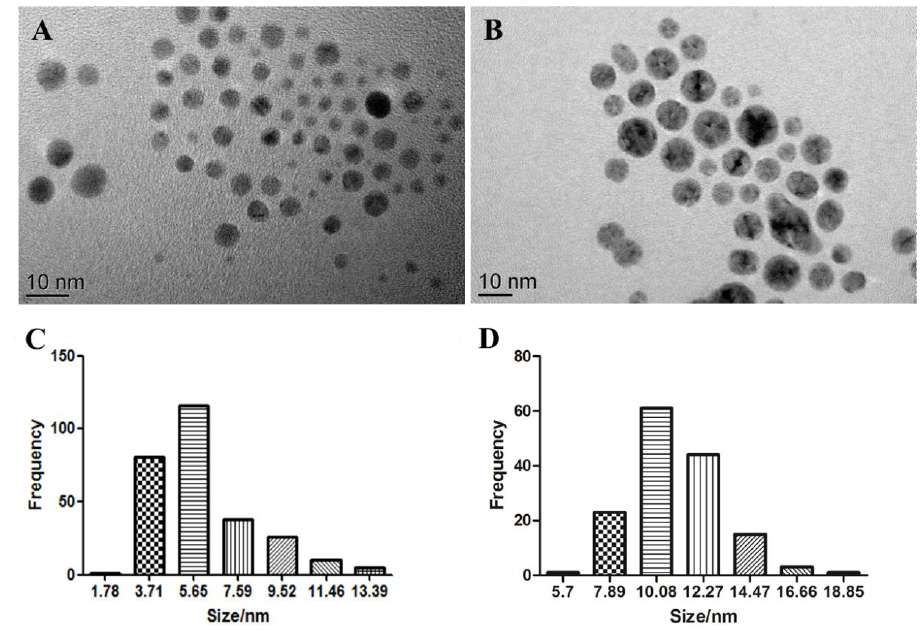
Figure 1. Transmission electron microscopy images of S4 ( A ) and S10 ( B ) silver nanoparticles (AgNPs). Histograms of the size distribution for S4 ( C ) and S10 ( D ).